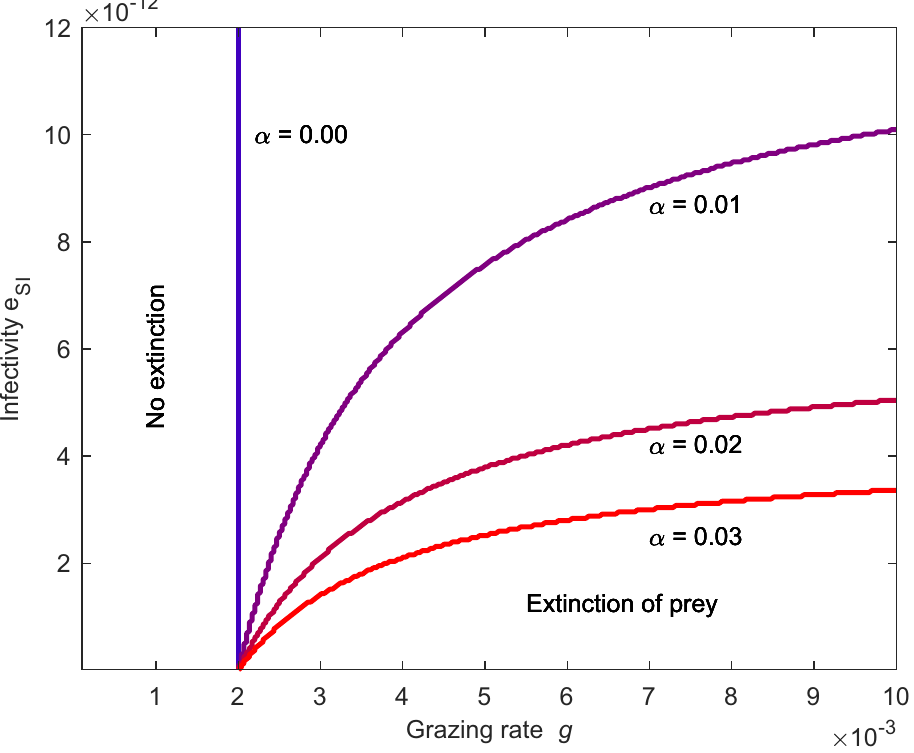
Fig 5. Predator grazing rate g affects the extinction of prey. Extinction of prey is possible if the predator’s grazing rate g is higher than the threshold defined by the prey’s growth rate. If the prey’s infectivity e SI is high, only a small fraction α of the prey population needs to be infective to escape the extinction. Prey growth rate is r C = 10.